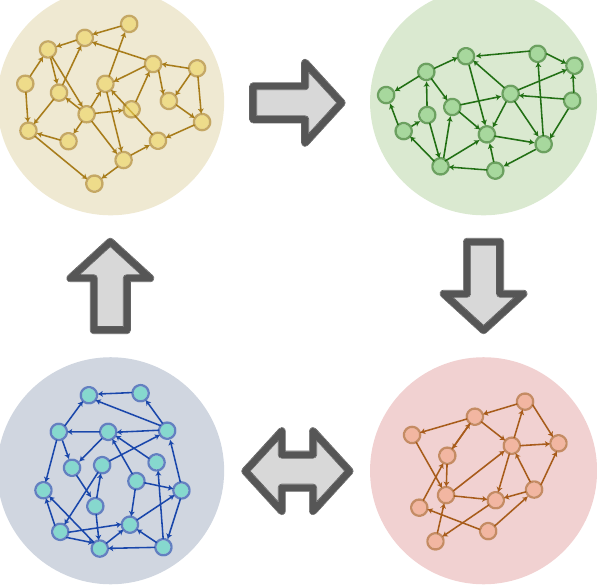
Figure 3. Network of networks. An illustration of a complex network of networks, composed of four sub- networks, orange, green, blue and red, which can be studied using the generalized analytical